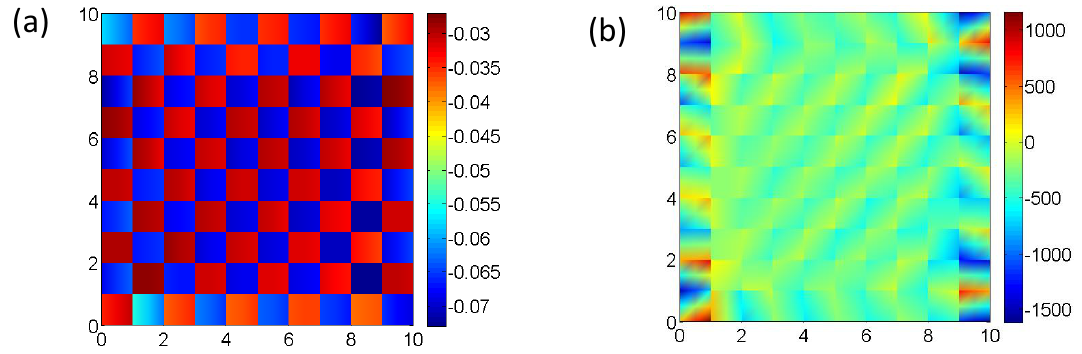
Figure 4. ( a ) The induced axial deformation gradient ( F 33 ) distribution in the plane y 2 - y 3 at y 1 = D /9, i.e., ( N α = 2 ) within the RUC of the small sample d 2 subjected to uniaxial compression loading; ( b ) the induced first Piola–Kirchhoff stress ( T 1 PK ) distribution in the plane y 2 - y 3 at 33 y 1 = D /9, i.e., ( N α = 2 ) within the RUC of the small sample d 2